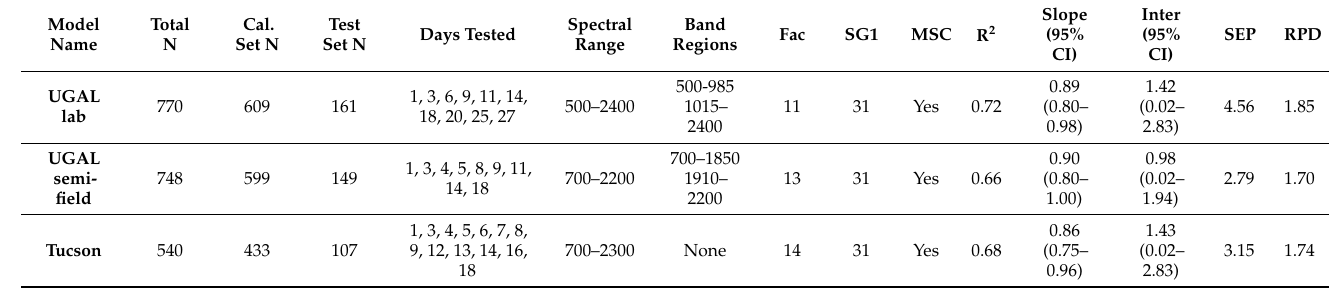
Figure 1. NIRS scanning and typical spectra. ( A ). Examples of mosquito positioning under the NIRS probe. The NIRS probe was positioned 3 mm above the Spectralon plate and ~1.5 mm above the mosquito thorax. ( B ). Average log(1/R) spectra from 1- (green line; n = 53), 9- (red line; n = 53) and 18-day-old (blue line; n = 60) mosquitoes. Wavelength across the visible and near-infrared spectrum is indicated on the X-axis. Table 1. Summary data for the generation of the NIRS models. Detailed in this table are the number of mosquitoes utilized for the prediction (Cal.) and cross validation (Test) sets, the spectral range and band regions selected from the model, whether SG1 or multiplicative scatter correction (MSC) was used, the number of factors (Fac), R 2 , slope and 95% confidence interval (CI), intercept (Inter) and 95% CI, standard error of prediction (SEP) and ratio of performance deviation